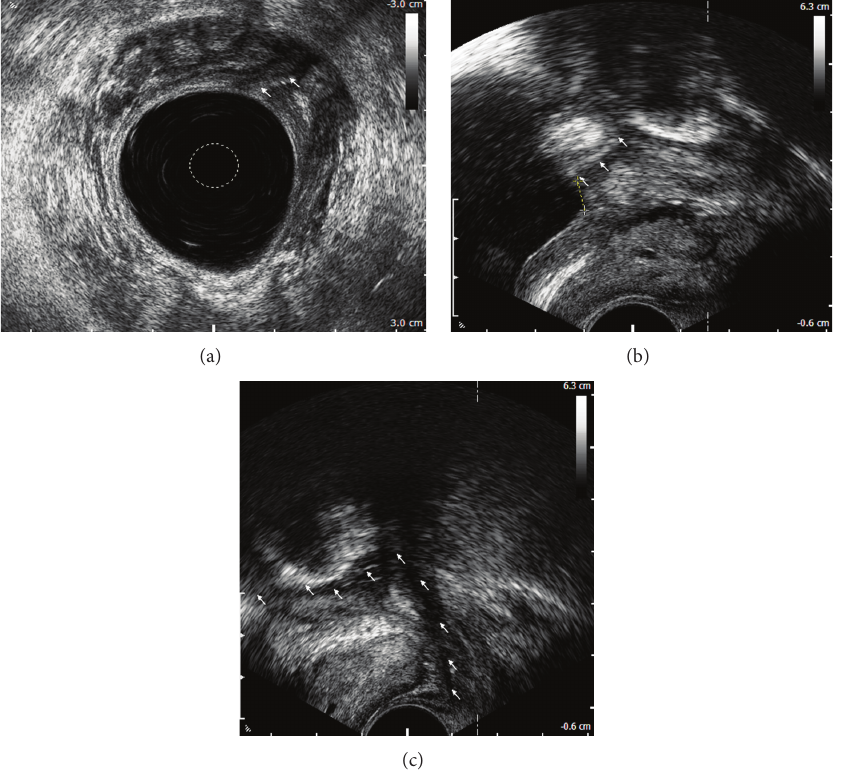
Figure 2: Rectovesical fistula: anorectal endosonographic view of a fistulous orifice in the urinary bladder (arrows) (a), transrectal ultrasonographic view of a fistulous orifice (arrows) located 6mm from the internal outlet of the bladder (crosses) (b), and transrectal ultrasonographic view of a fistulous tract adjacent to the left lobe of the prostate (arrows) (c).